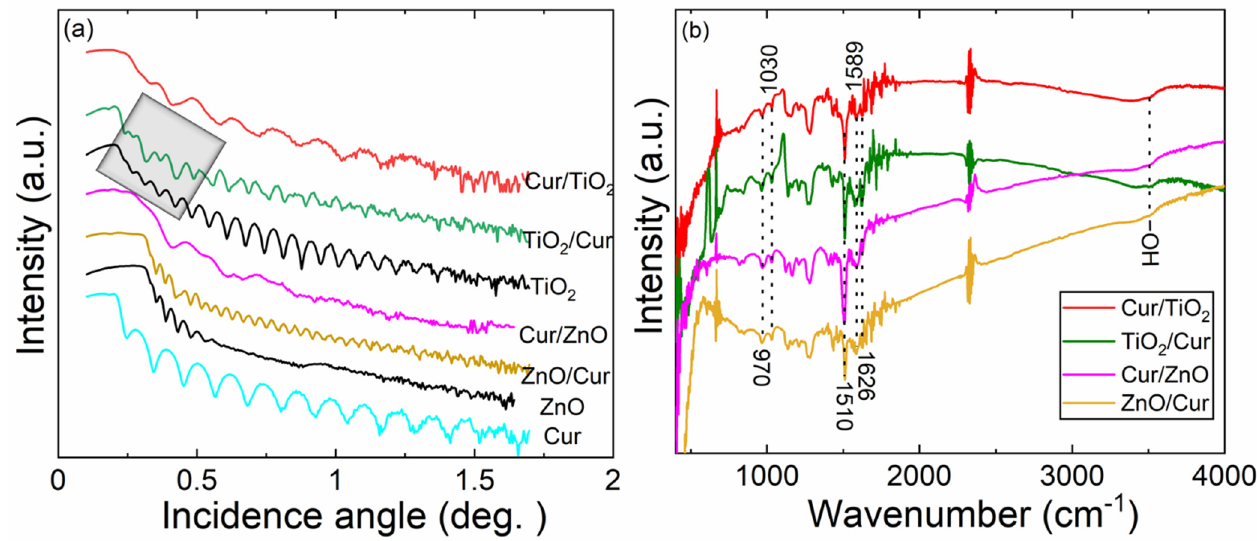
Figure 5. Characterization data for double-layer films: ( a ) XRR patterns, and ( b ) FTIR spectra (peaks due to Cur indicated) for the different metal oxide/Cur DL films, together with data for Cur, ZnO and TiO 2 films for reference. An illustrative example of the change in the XRR fringe shape due to the DL structure is highlighted.